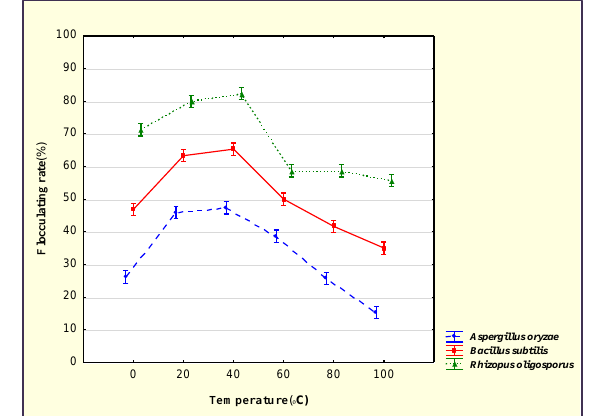
Figure 2. Thermostability of bioflocculants The presence of different functional